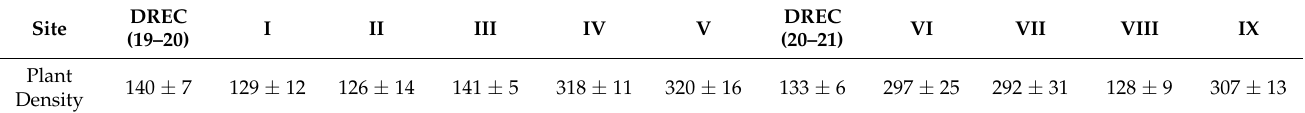
Table 4. Mean ( ± standard deviation) plant population at different sites (plants per m − 2